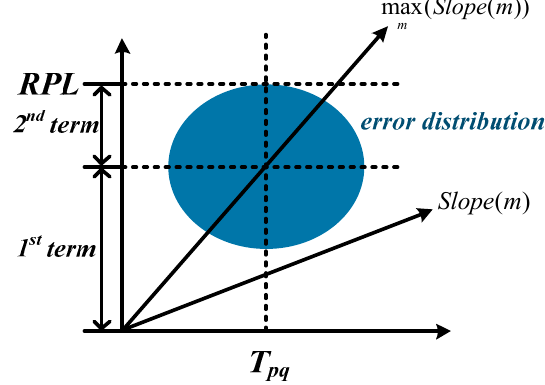
T (1st term) and the inverse of the cu-